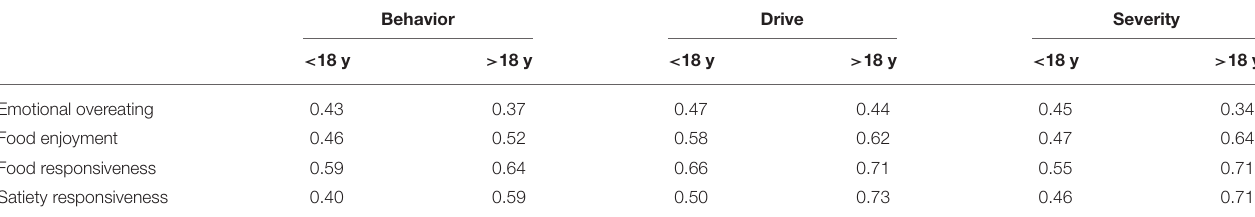
TABLE 3 | Zero-order correlations between Hyperphagic dimensions and convergent variables distinguished by age group.